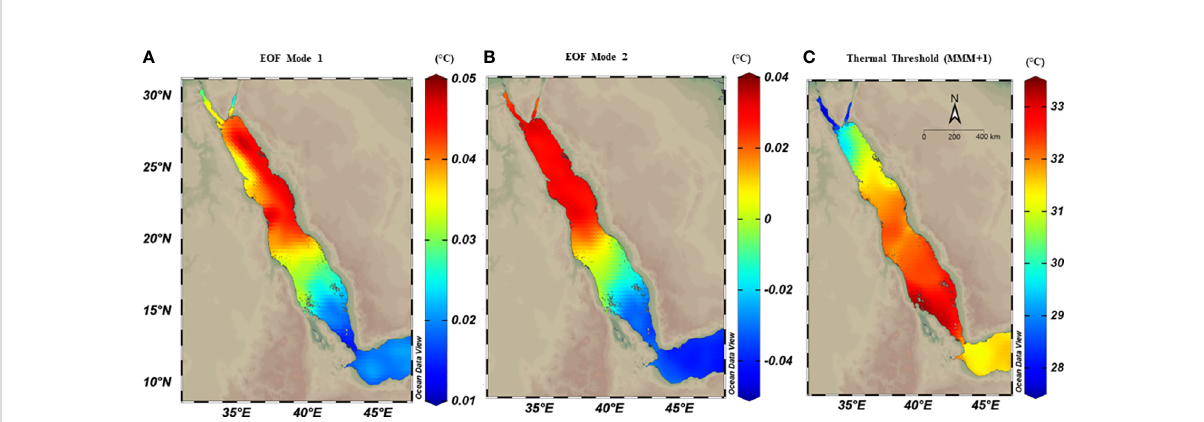
FIGURE 2 Spatial distribution maps of thermal anomalies using empirical orthogonal function (EOF) analysis on OSSIT remote sensing data (1982-2020) along the Red Sea. The fi rst two modes of EOF (explaining 61%) were extracted and each mode was mapped separately. Both modes showed relatively higher thermal anomalies in the northern region compared to the southern regions. (A) The fi rst mode (explained 35% of the total SST anomaly variance), and showed higher SST anomalies in the northern region, with a zonal gradient between east and west; (B) The second mode (explained 26.3% of SST anomaly variance) with a pronounced latitudinal difference. (C) spatial distribution of thermal threshold (°C) calculated as the maximum monthly mean over 39 years plus 1°C (MMM+1), where spatial variability exhibited a higher threshold in the southern region (ca.33°C) compared to the northern region